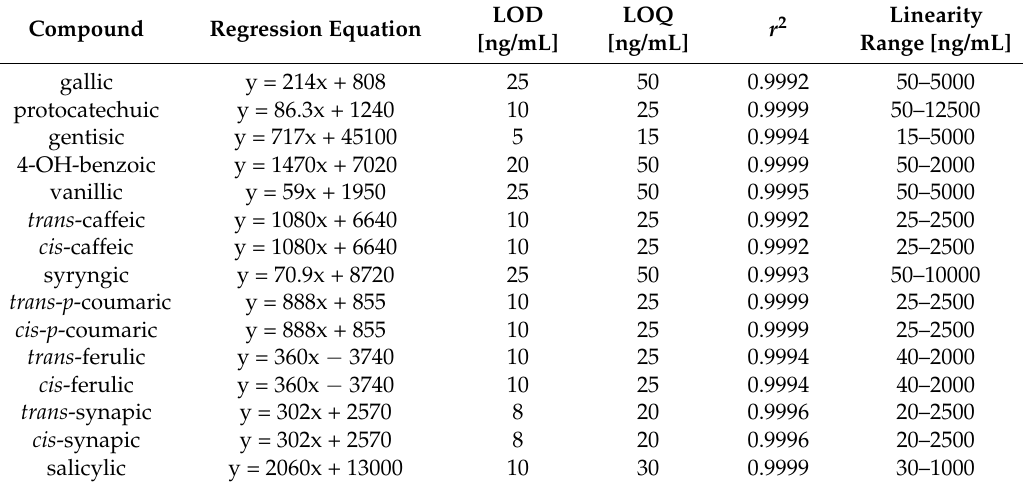
Table 1. Analytical parameters of LC-MS/MS quantitative method; data for calibration curves, limit of detection (LOD) and limit of quantification (LOQ) values for each analyzed phenolic